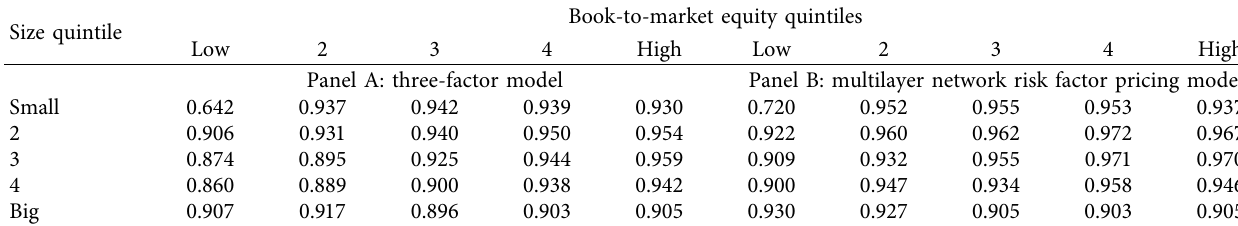
Table 2: Fitting effect of different factor models.